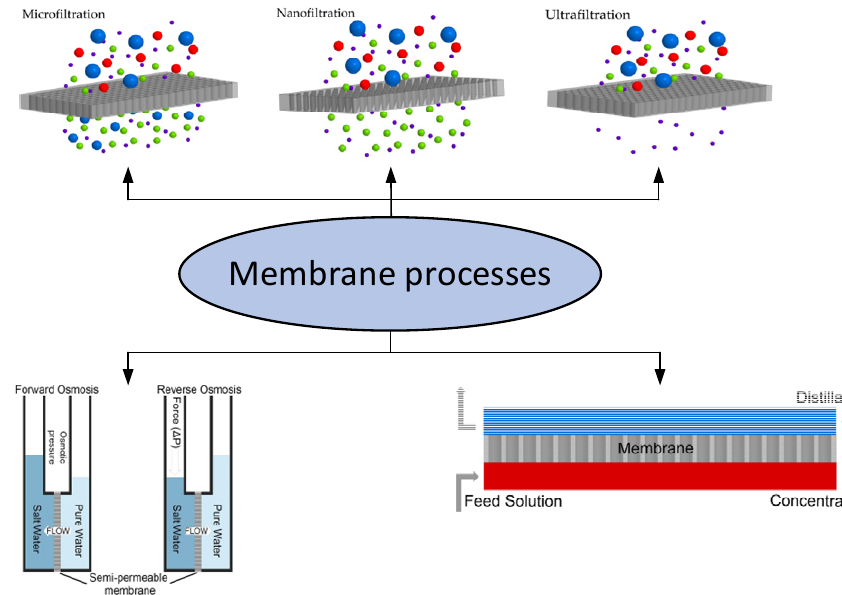
Figure 1. Types of membrane processes.